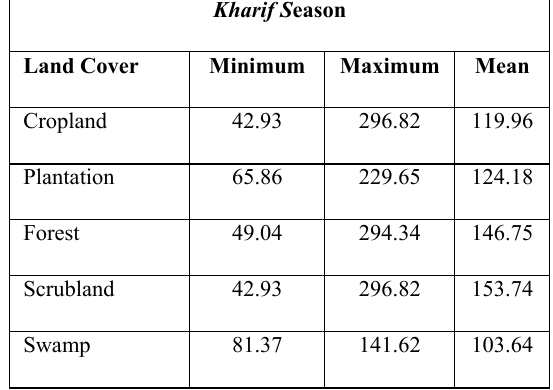
Table 4. Zonal Averaged Rainfall over the Land Covers of Tamil Nadu during the Kharif season of 2017